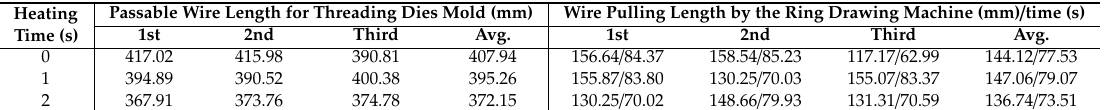
Table 12. Results based on wire pulling speed: k1(1.86 m / s).